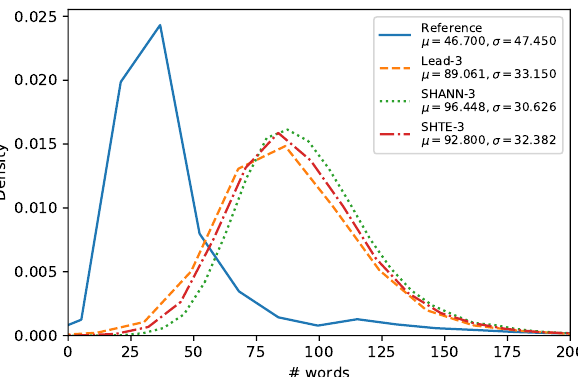
Figure 6. Word-length distribution of system generated summaries with k = 3 in comparison to human reference summaries for